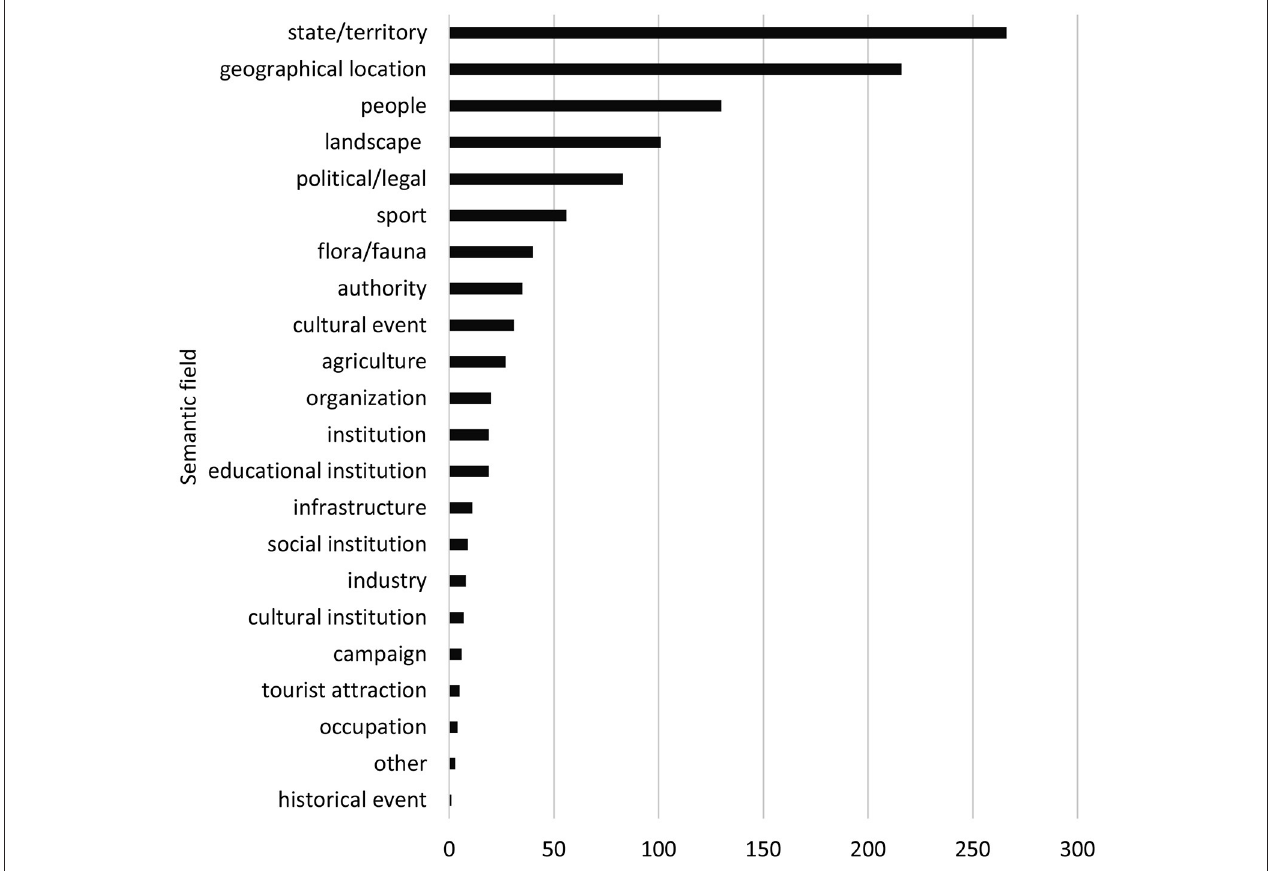
FIGURE 2 | Unadapted anglicism tokens per semantic